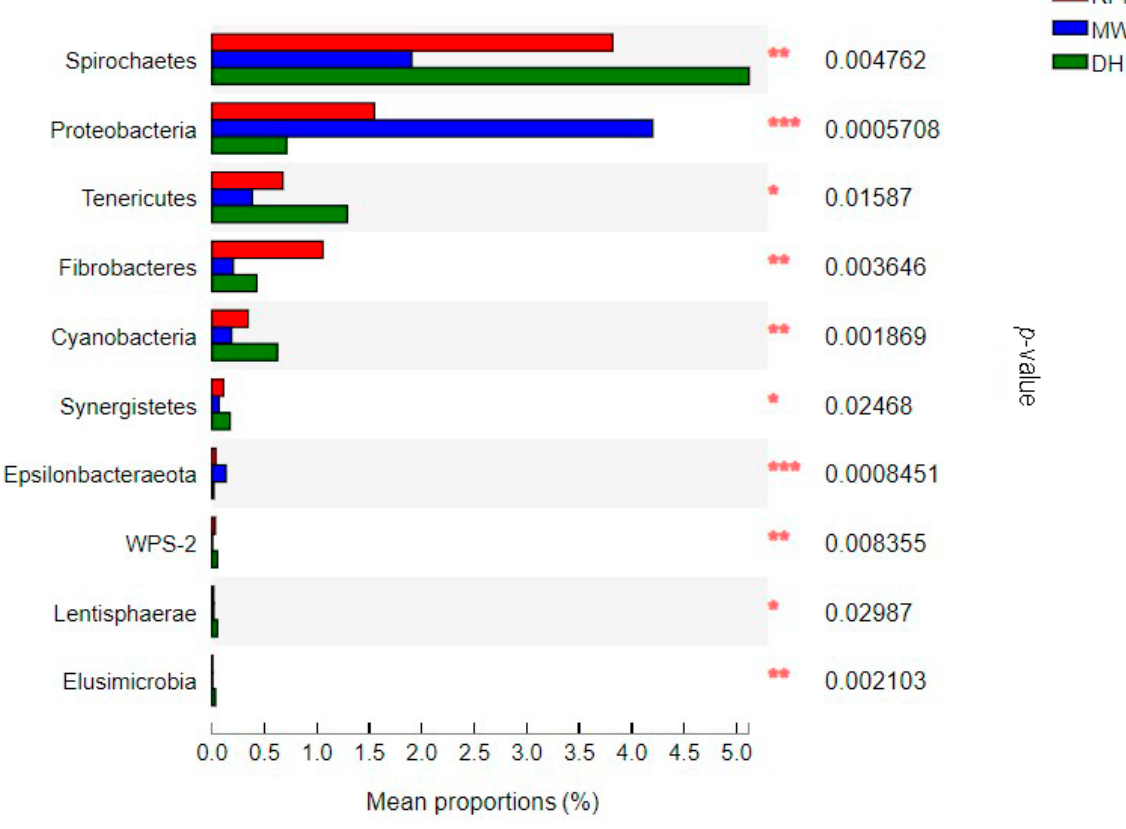
Figure 6. The bar plot shows the bacterial phylum with significant differences among RPH, DH and MWA. * p < 0.05, ** p < 0.01 and *** p < 0.001. Other phyla with relative abundance lower than 0 order of magnitude in RPHs are Tenericutes , Patescibacteria , Cyanobacteria , Verrucomicrobia , Actinobacteria , Synergistetes , Epsilon- bacteraeota , WPS-2, unclassified_k__norank_d__Bacteria, Armatimonadetes , Lentisphaerae , Planctomycetes and Elusimicrobia Chlamydiae and Chloroflexi were not found in RPHs, and the former was also not found in MWAs (Supplementary Table S2). At class level, the dominant two classes were Clostridia and Bacteroidia, which had relative abundance at 1 order of magnitude. The Clostrida and Bacteroidia had significant differences between CPHs and RPHs (Figure 7), and Clostridia displayed significant differ- ences among the RPHs, DHs and MWAs (Figure 8). There are 11 classes that displayed relative abundance at 0 order of magnitude in RPHs, which were Kiritimatiellae , Spirochaetia , Deltaproteobacteria , Negativicutes , Erysipelotrichia , Fibrobacteria , Verrucomicrobiae , Mollicutes , Bacilli , Saccharimonadia and Melainabacteria (Supplementary Table S3). The other 19 classes had relative abundance lower than 0 order of magnitude (Supplementary Table S3). Among them, classes of Bacilli , Negativicutes and Gammaproteobacteria had significant differences among the RPHs, DHs and MWAs (Figure